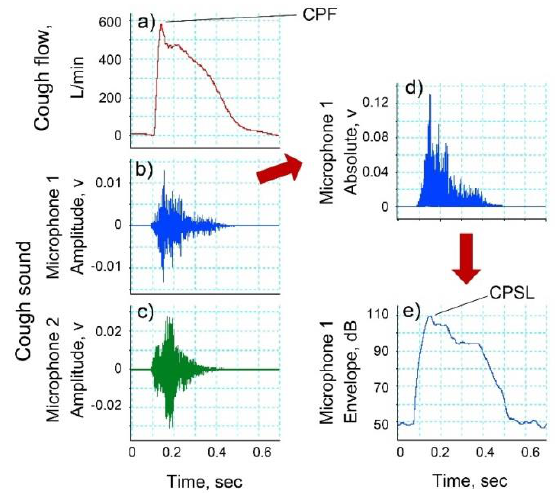
Figure 2. Examples of cough flow and cough sounds measured by microphones 1 and 2.